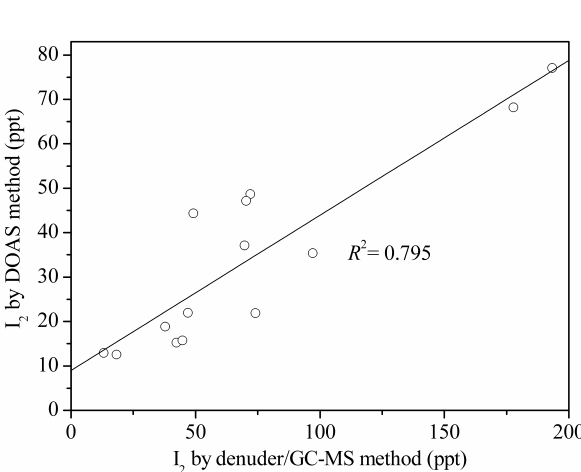
Fig. 8. Comparison of I 2 mixing ratios measured by denuder/GC- MS and